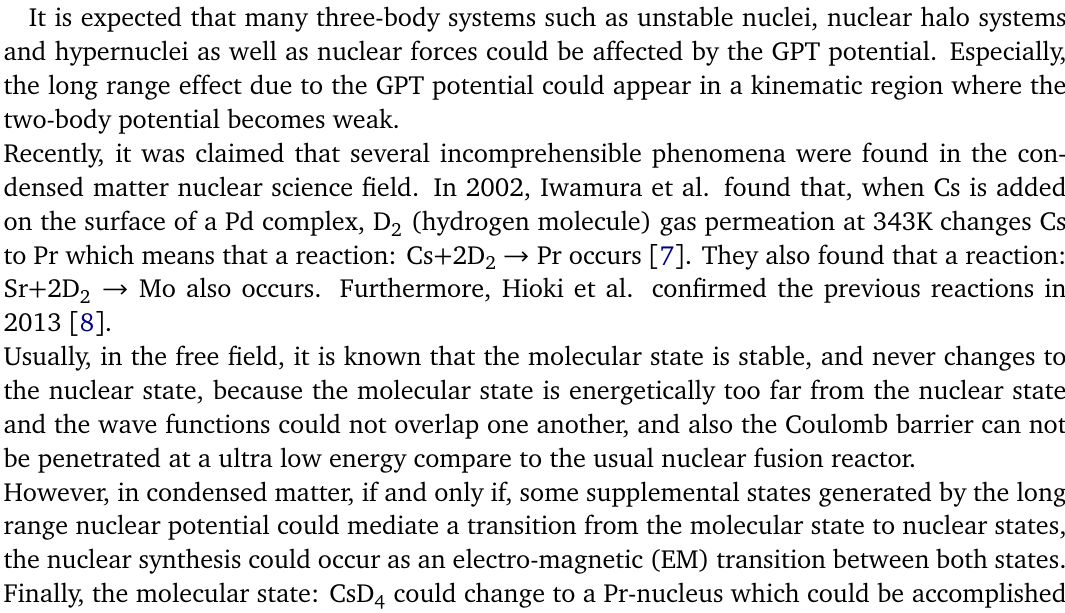
a 2 γ + 2 / [ r ( r + a ) 2 γ + 2 ] is illustrated, which is given by 0 = 0) and below the Q2T ( E = − ε , B B ( < 0 ) , a potential depth 0